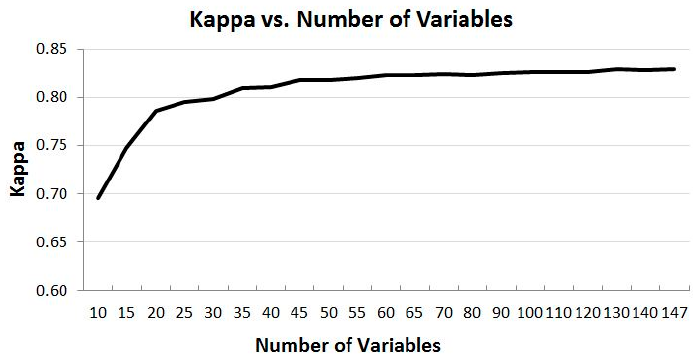
Figure 5. The relationship of Kappa and the number of the most important variables. Kappa increases with the increase of the number of variables.